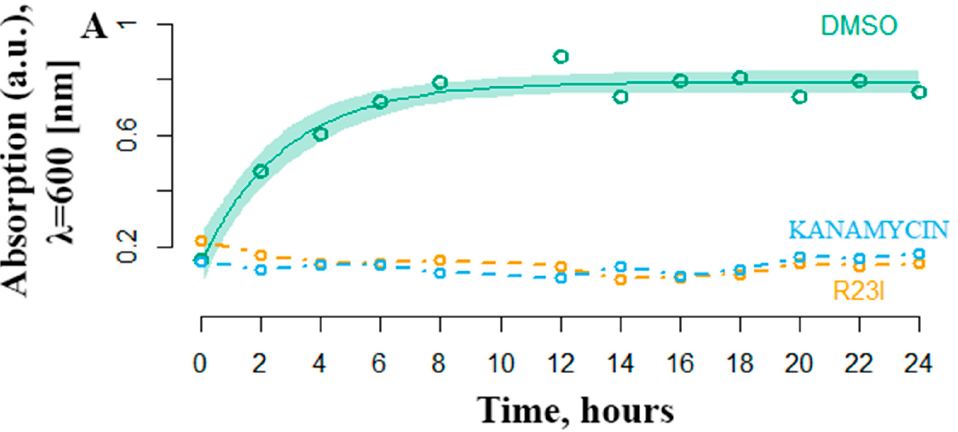
Figure 5. Temporal dependence of changes in the optical density of T. thermophilus cells with the addition of kanamycin (commercial antibiotics) and the R23I peptide. As a control, the addition of DMSO was used. The ordinate is the optical density at a wavelength of 600 nm. The abscissa axis is the sampling time.